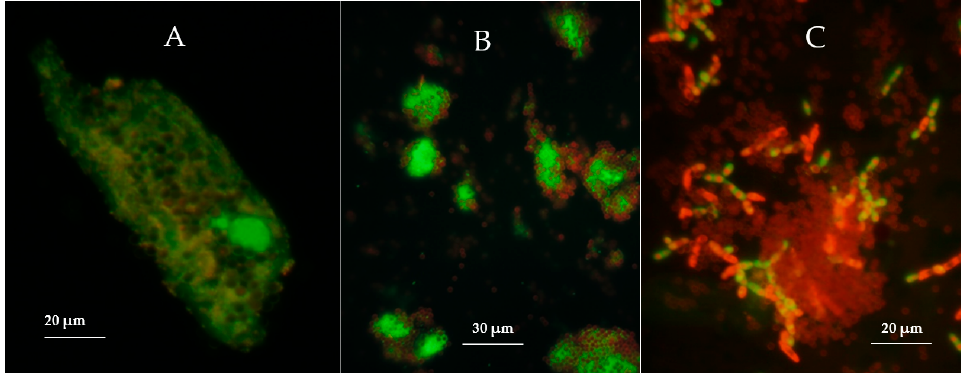
Figure 7. Nonspecific capture of non-target cells by MBL-MB. Epithelial cells present in urine samples—an epithelial cell covered with MB is shown ( A ), Mixed flora—clusters of bacteria—bright green—are surrounded by MB—dark red ( B ), Fungal presence—Candida spp. captured by the MBL-MBs ( C ).